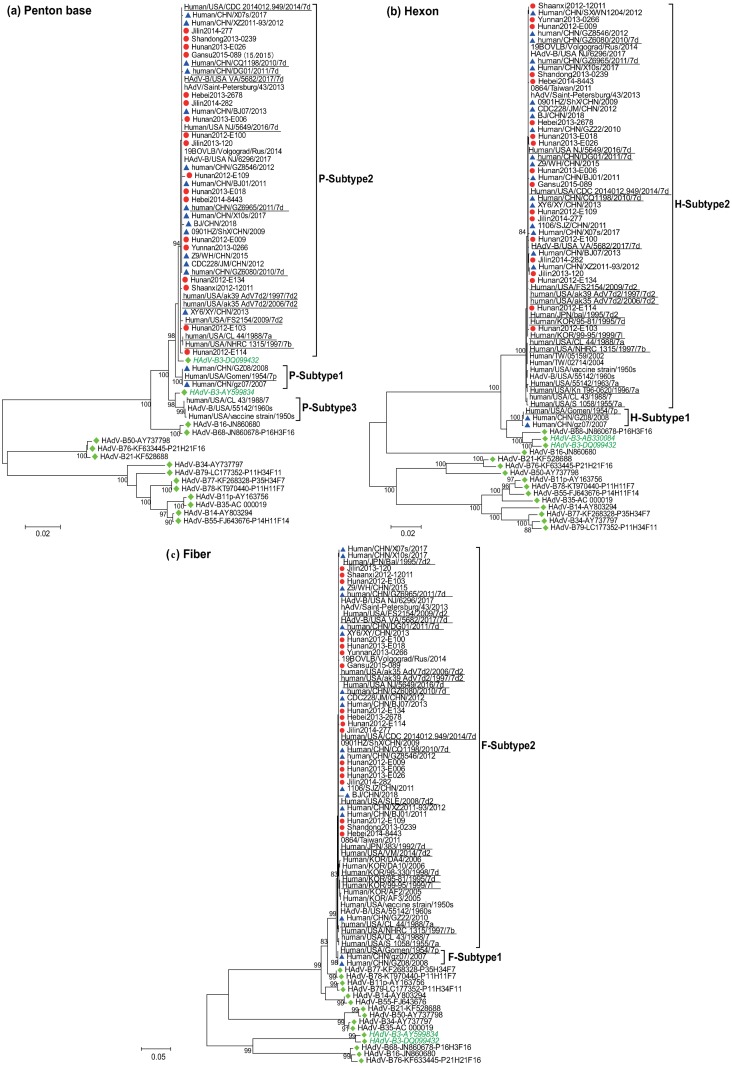
Neighbor-joining phylogenetic tree of HAdV-7 sequences based on penton base (a), hexon (b), and fiber genes (c).The red circles indicate the HAdV-7 strains identified in this study; blue triangles indicate the HAdV-7 strains isolated in China from GenBank database; underlined strains are known types of HAdV-7 identified by REA; green diamonds indicate other members within species B.